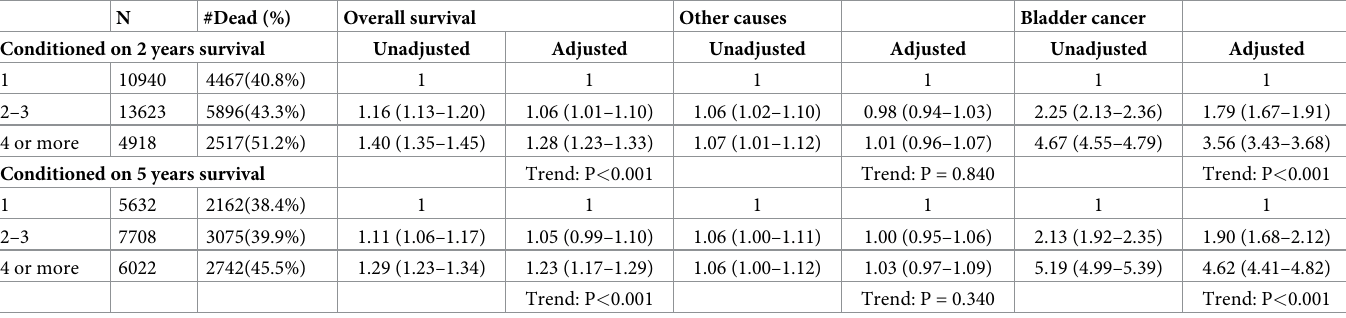
Table 3. Hazard ratios (HR) with 95% confidence intervals from a Cox proportional hazards model estimating risk of dying from all causes, of causes other than bladder cancer and of bladder cancer associated with number of postoperative transurethral procedures in the NMIBC